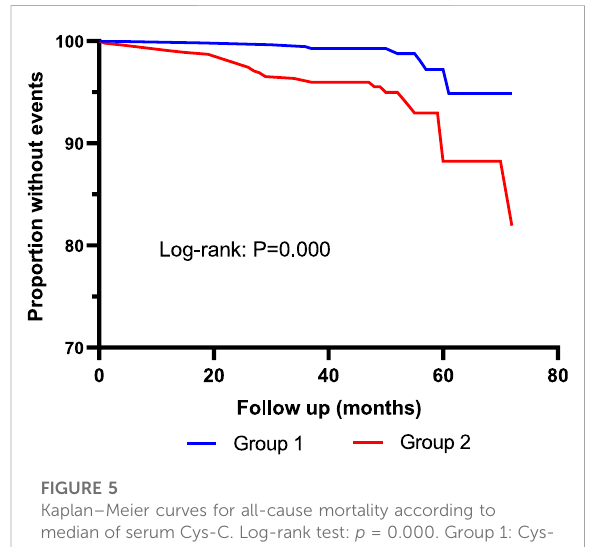
FIGURE 5 Kaplan – Meier curves for all-cause mortality according to